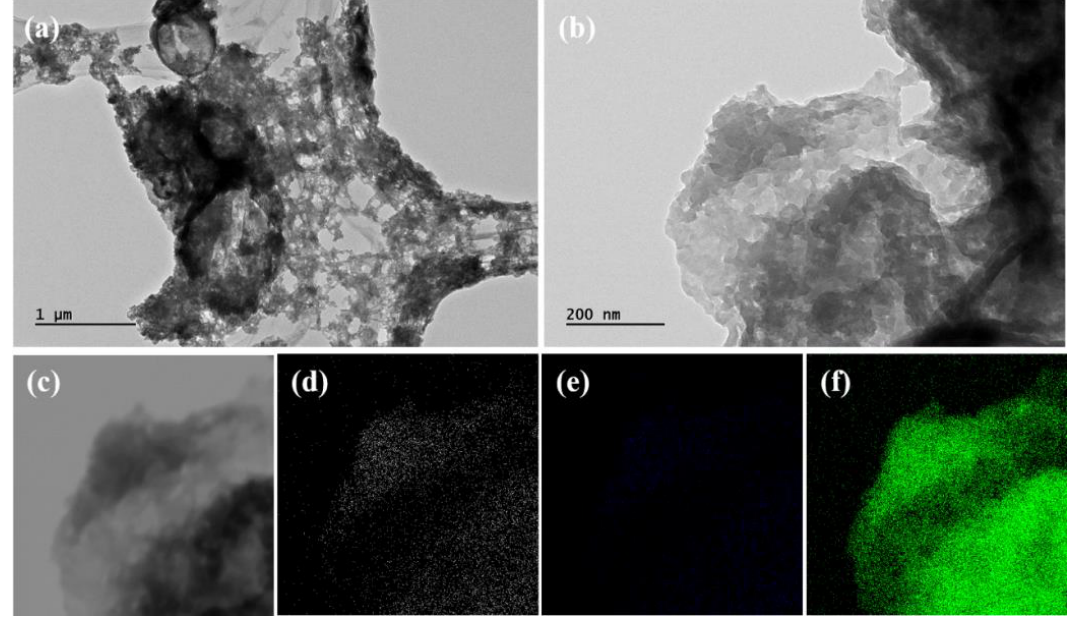
Figure 5. TEM images of poly(S-MVT) (15% MVT): ( a ) low magnification TEM image, ( b ) high magnification TEM image, ( c ) selected area image for mapping and corresponding elemental mappings of ( d ) carbon, ( e ) nitrogen, and ( f ) sulfur for poly(S-MVT) (15% MVT).